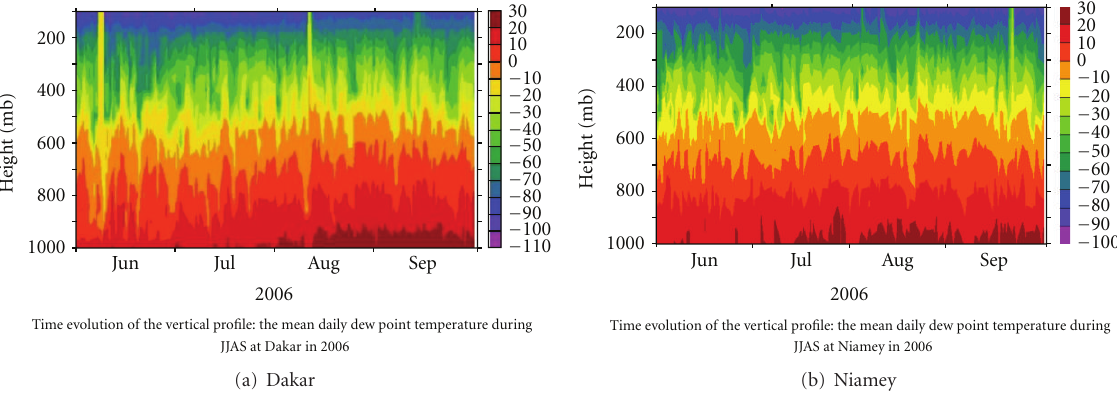
Figure 6: Dew point temperature profiles in Dakar and Niamey at 0000 UTC and 1200 UTC of JJAS